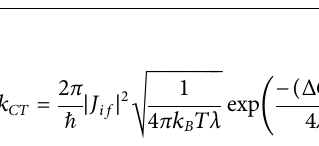
FIGURE 4 | LCmaker WaNo window in SimStack (A) . Options in the right window are set for the PCU topology. Description of all options available is given in Supplementary Table S1 . Main functionality of LCmaker (B) .